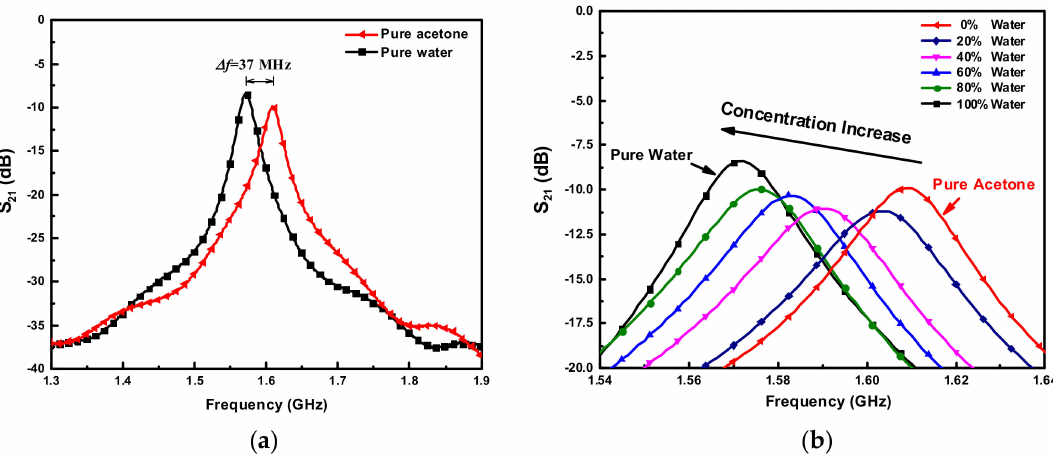
Figure 14. Measured transmission responses S 21 of the proposed sensor for ( a ) pure water and acetone and ( b ) acetone/water mixtures in various